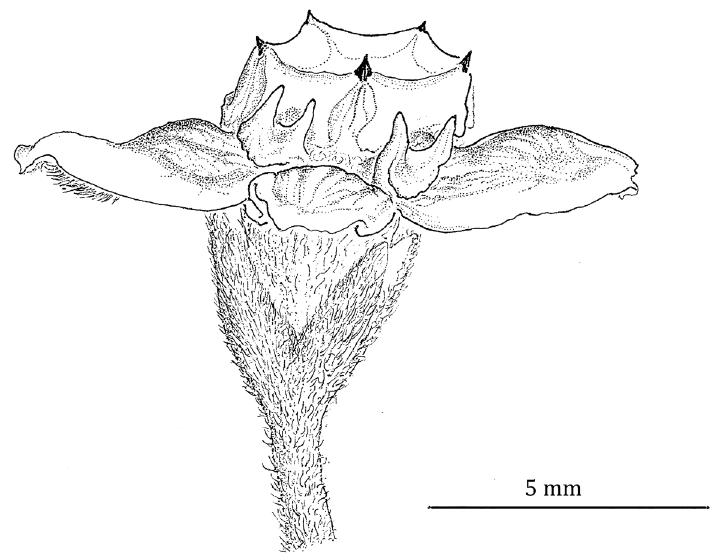
Figure 2. Flower of Lachnostoma ecuadorensis Morillo ( Homeier et al. 1174 ,